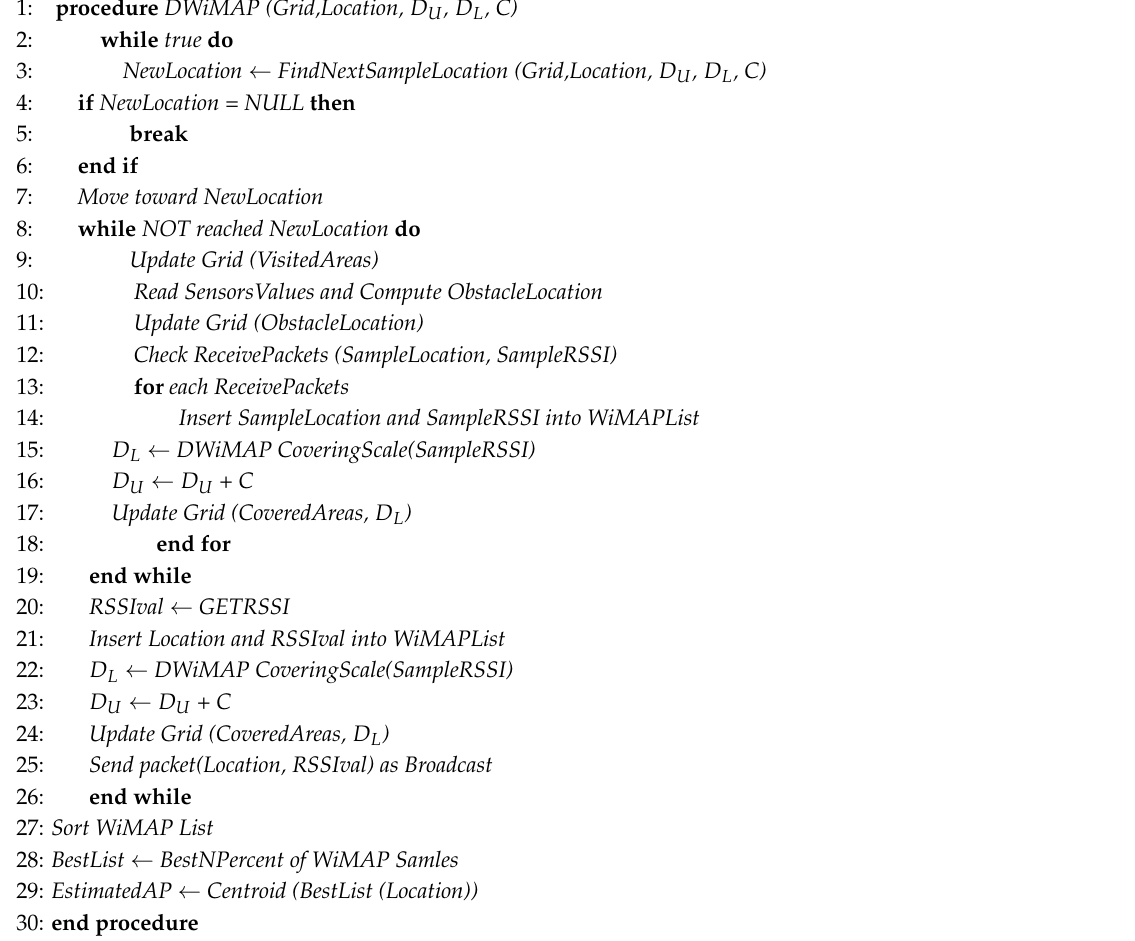
Algorithm 3 Distributed